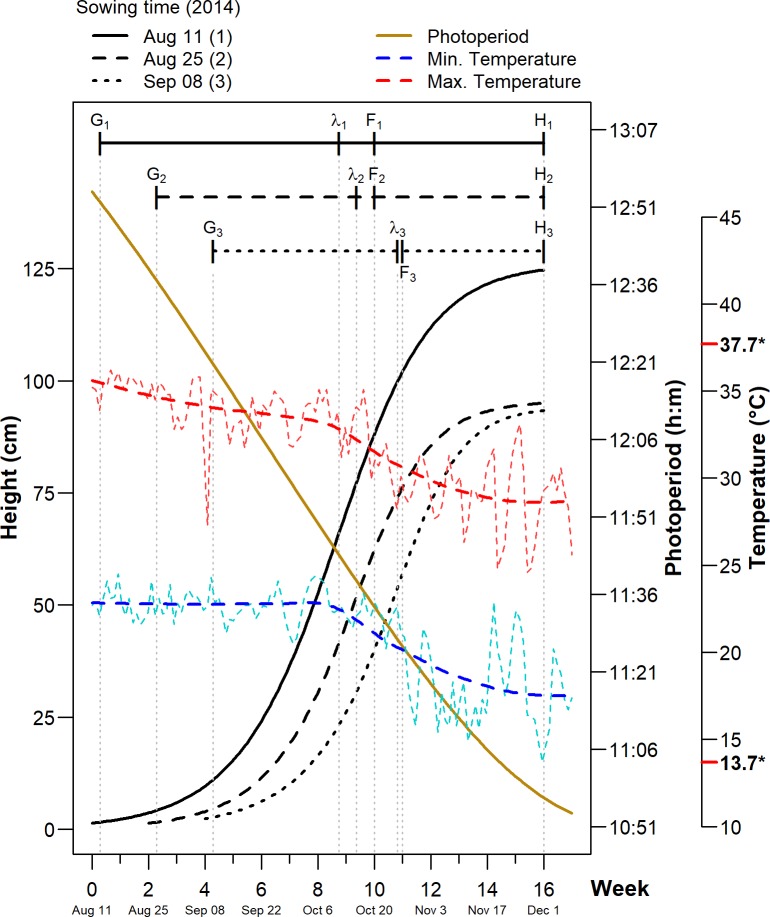
Fitted (sigmoid) Richards height models for three sowing times.The minimum and maximum weekly temperatures are displayed as two fluctuating time series (blue and red dashed lines), with their corresponding LOESS [30] trends superimposed. The decreasing line corresponds to the estimated photoperiod in the northern lowlands of Yucatan (meteorological station at the Autonomous University of Yucatan, Merida, Mexico). The phenological stages of chia plants are also shown: G = germination; λ = point of inflection; F = emergence of inflorescences; H = harvest. Numbers indicated with an asterisk next to the temperature axis indicate the minimum and maximum temperatures reached in 2014–2016, for the same study area and interval of weeks analyzed in the present investigation.